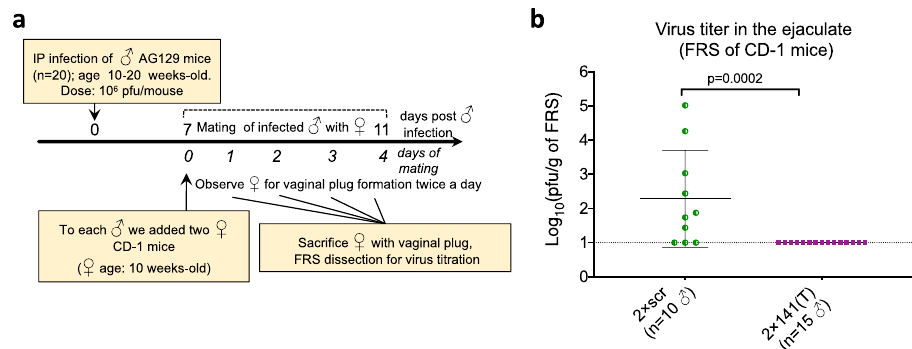
Fig. 4 Genome targeting for mir-141 restricts ZIKV shedding into the semen between 7 and 11 dpi. a Experimental design. Male AG129 mice were infected IP with 10 6 pfu of 2 × scr or 2 × 141(T) virus, and between 7 and 11 dpi mice were allowed to mate with two CD-1 females in the individual cages. b Mean virus titer ± SD in the ejaculate of AG129 mice that was deposited into FRS of CD-1 mice. Each dot represents an average ZIKV titer in the FRS of CD- 1 females that developed vaginal plug (one or two females per cage) after mating with ZIKV-infected male partner. The dashed line indicates the limit of virus detection: 1.0 log 10 (pfu/g of FRS). Differences between viral titers in the FRS were compared using two-tailed Mann – Whitney